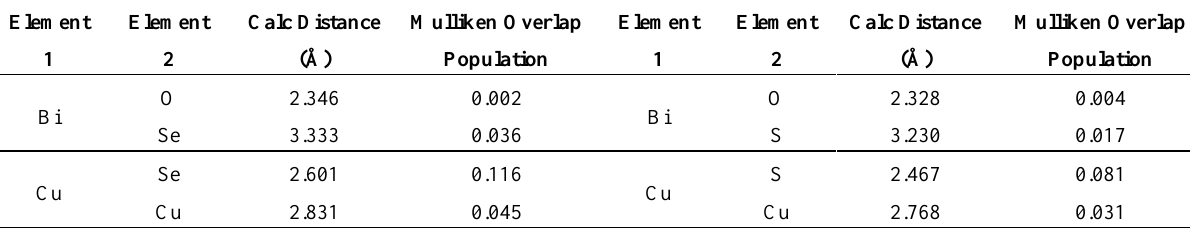
Table 2. Mulliken population analysis.